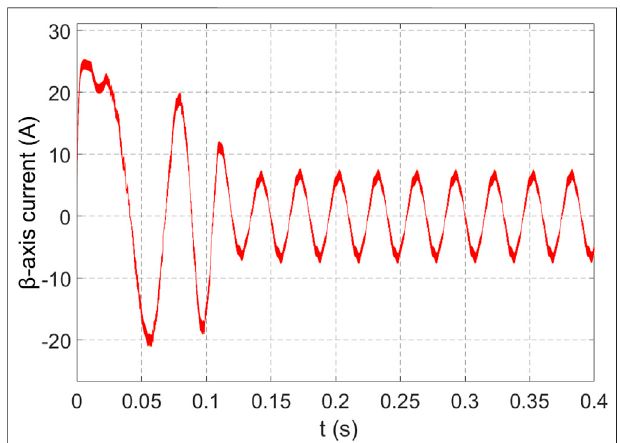
FIGURE 7 | Identi fi cation value of β -axis